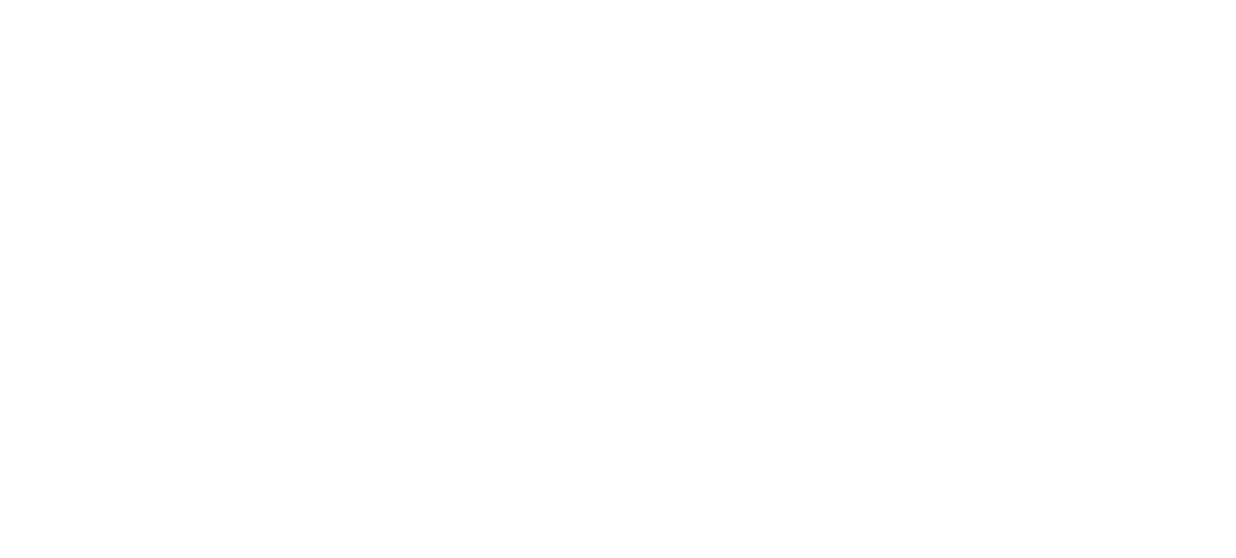
Frontiers in Communication |